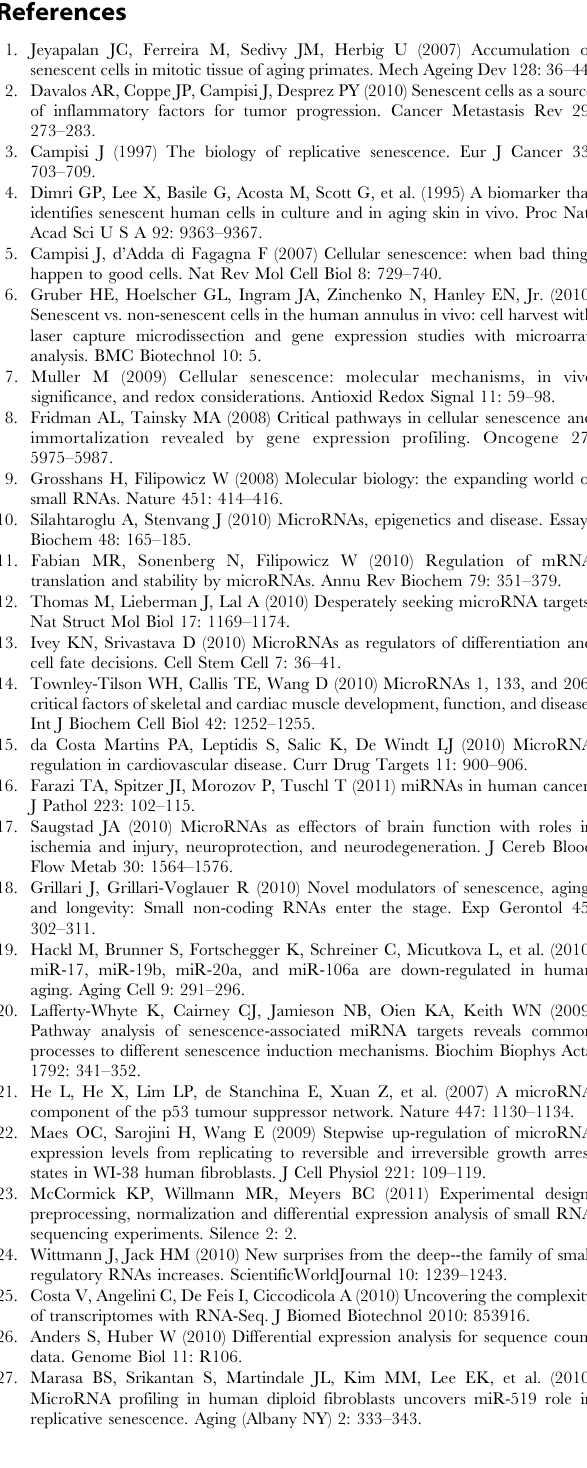
Table S5 Potential target genes downregulated by senescence- induced miRNA overexpression in both types of fibroblasts, IMR90 and MRC5. Table S6 Potential target genes upregulated by senescence- induced miRNA underexpression in both types of fibroblasts, IMR90 and